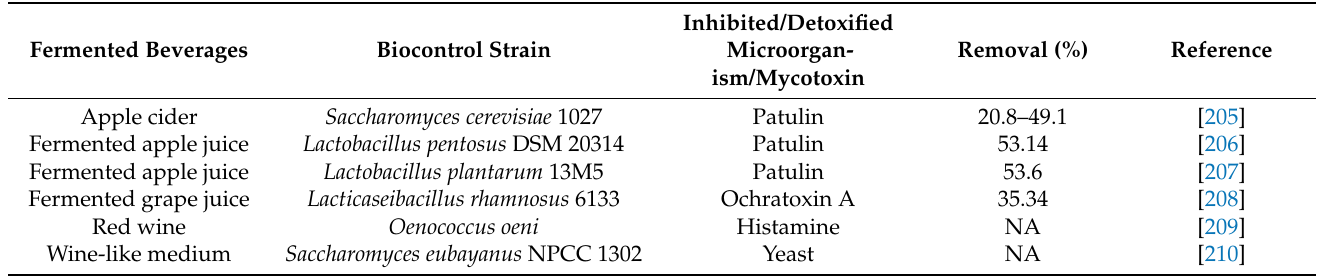
Table 2. Selected recent studies (2020–2022) regarding biological decontamination in fermented